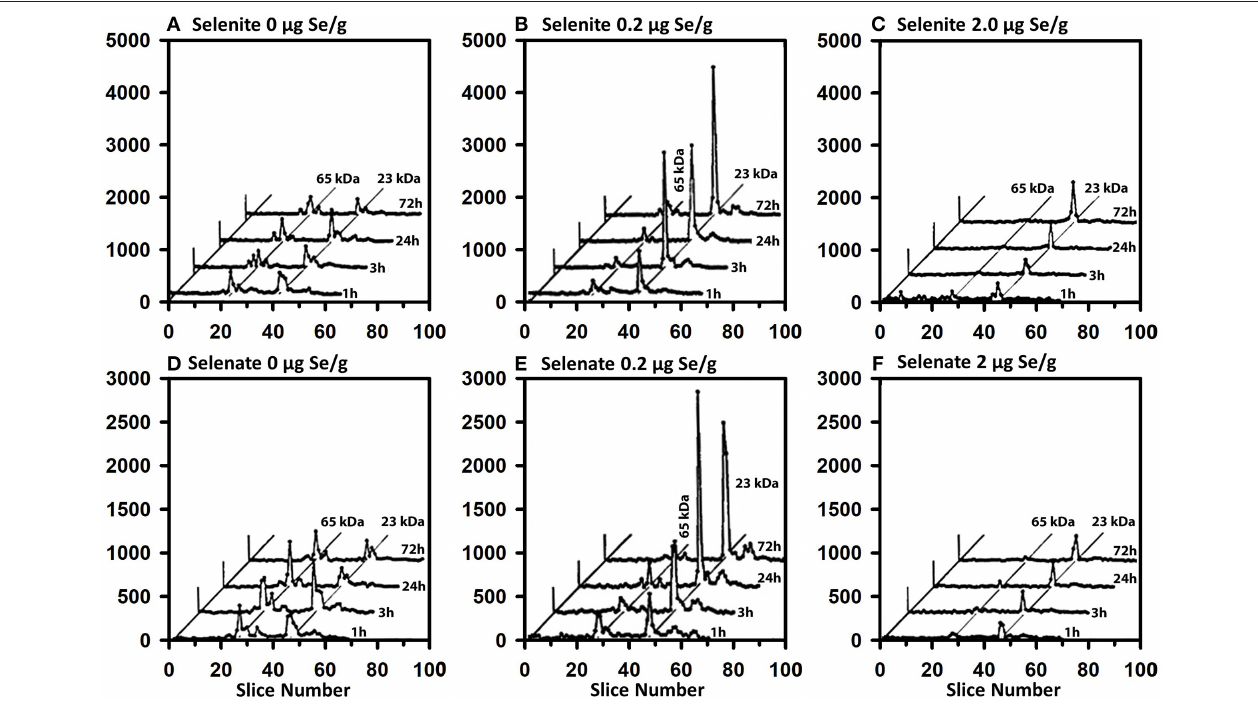
FIGURE 7 | Incorporation of 75 Se from [ 75 Se]selenite (A–C) and [ 75 Se]selenate (D–F) into liver cytosolic proteins. Rats were fed the indicated dietary Se levels as selenite for 50–80 d, injected iv with 50 µ Ci of tracer 75 Se-labeled selenite or selenate, and killed at 1, 3, 24, or 72h afer dosing. After homogenization and centrifugation at 105,000 x g, cytosols (1,500 µ g protein) were separated using gradient SDS/PAGE as described for Figure 3 ( n = 24 total rats). Liver GPX1 is 23 kDa, and the 65 kDa species are similar to the isoenzymes of